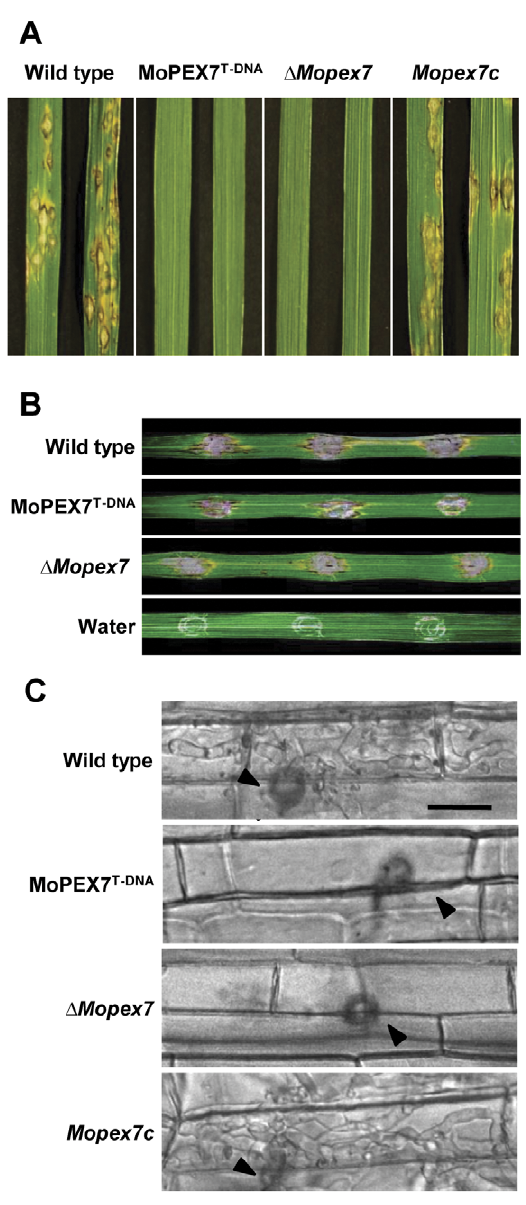
Figure 3. Pathogenicity of D Mopex7 . (A) Spray inoculation. Spore concentration was 1 6 10 5 conidia/ml. (B) Infiltration inoculation. Conidial suspension was 5 6 10 4 conidia/ml. (C) Rice sheath infection 48 h after inoculation. Arrows indicate appressoria. Bar=20 m m.